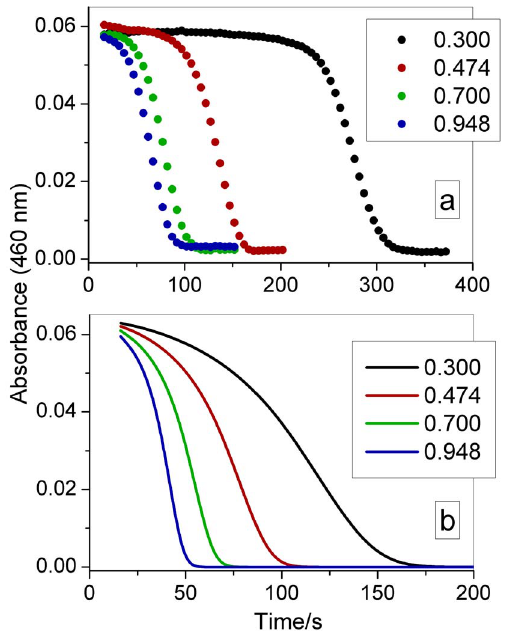
Figure 4. Effect of the acid concentration on the clock time. The initial concentrations after mixing the reactants in the cuvette were as follows: [HClO 4 ] as indicated in the figures (mol L 2 1 ), [O